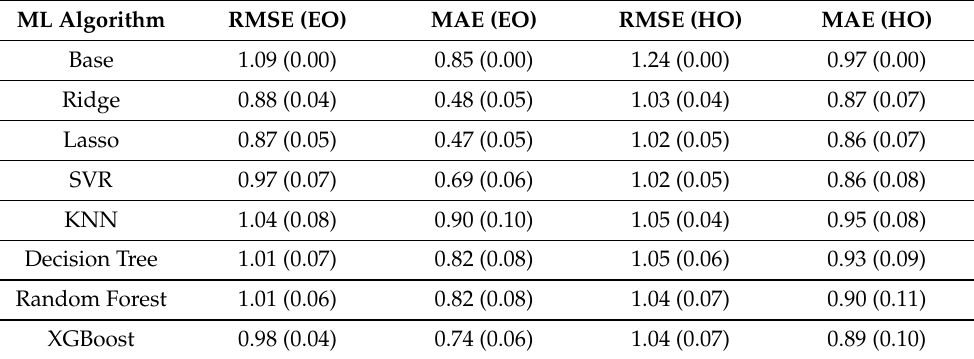
Table 6. EHO prediction results (regression problem) using U-F and I-F features. Nested cross- validation with 10 outer and five inner splits. EO (Eudaimonic orientation) and HO (Hedonic orientation). Numbers are the mean value of 10 outer splits. Numbers in parenthesis indicate the standard deviation